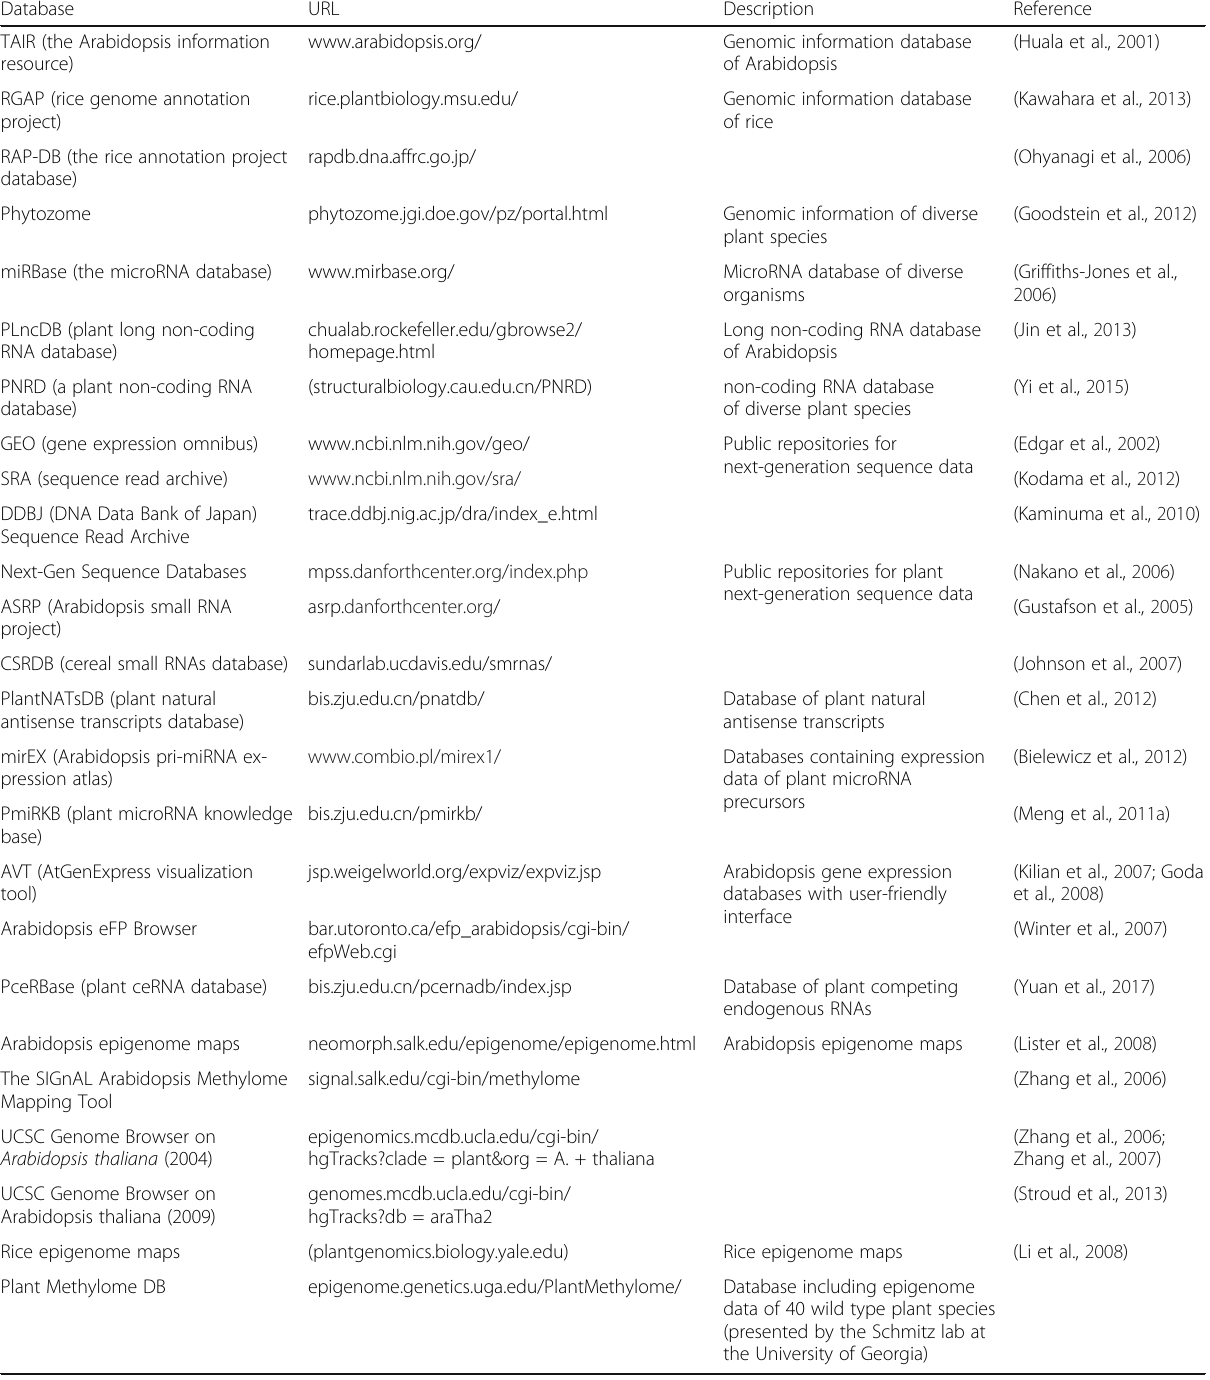
Table 1 List of databases for plant small RNA research